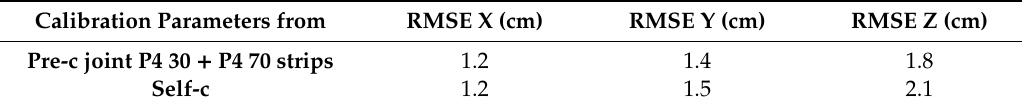
Table 5. Phantom4 single strip at 30 m adjustment with 17 GCP: RMSE on 27 CP coordinates computed with two di ff erent camera parameters settings in the BBA. Calibration Parameters